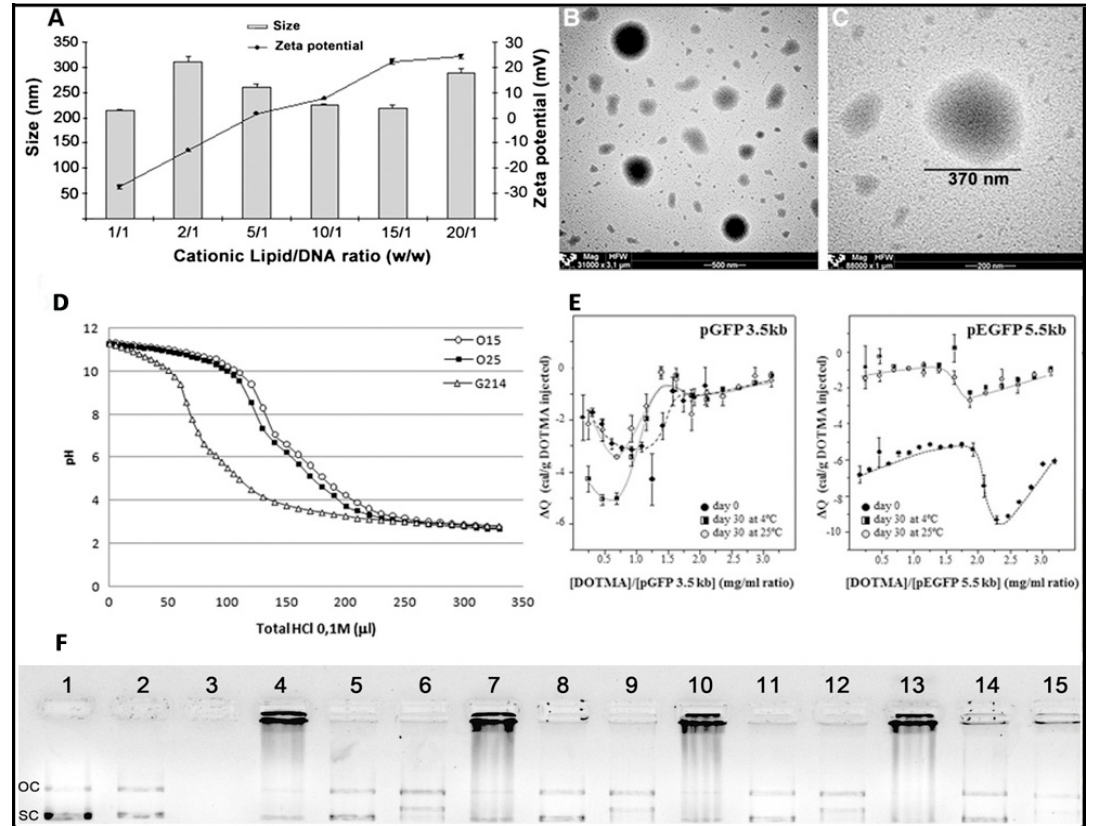
Figure 4. Physicochemical characterization of niosome formulations in terms of size, superficial charge ( A ), and morphology ( B, C ), adapted with permission from Puras et al. [91]. Buffering capacity assay ( D ) and isothermal titration calorimetry ( E ), adapted with permission from Agirre et al. [101]. Copyright 2019, Elsevier B.V and Gallego et al. [9]. Copyright 2014, Elsevier B.V. DNA binding capacity, release and protection from enzymatic digestion ( F ), adapted with permission from Puras et al. [91]. Copyright 2014, Elsevier B.V. OC, Open circular, SC